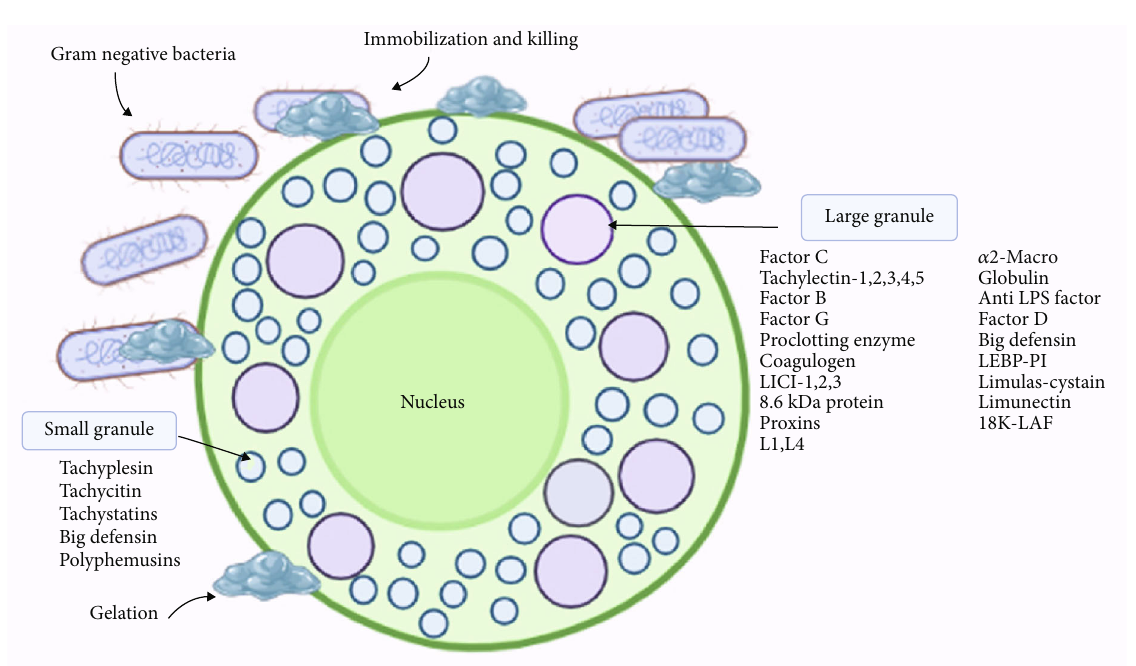
Figure 5: Defense systems associated with defense molecules of horseshoe crab hemolymph and their localization